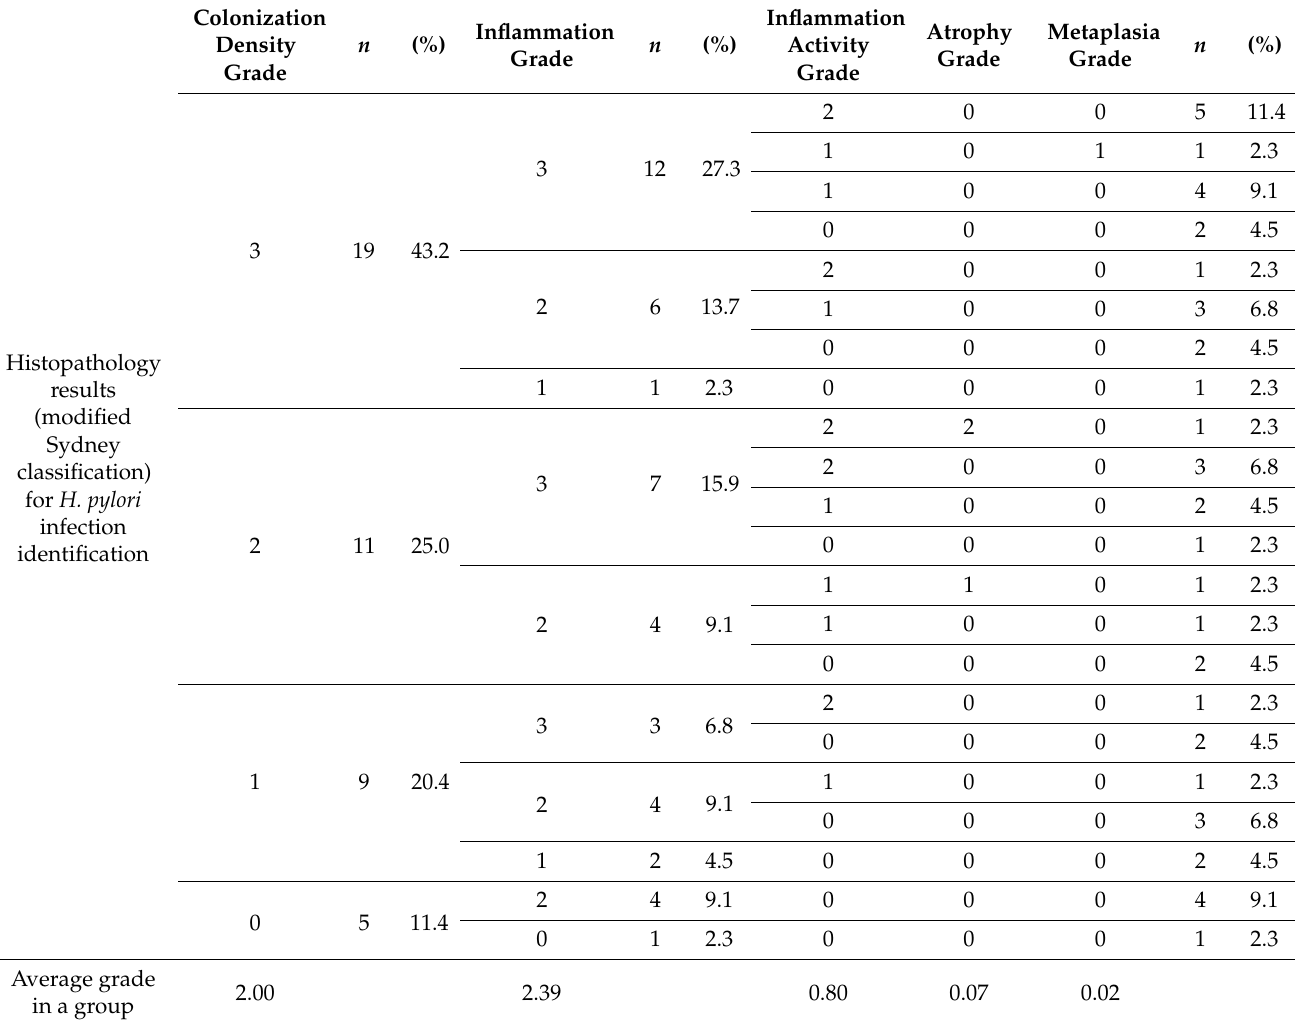
Table 3. The detailed distribution of histopathological investigation grades (modified Sydney classifi- cation) observed in the group of patients with positive PCR results ( n =